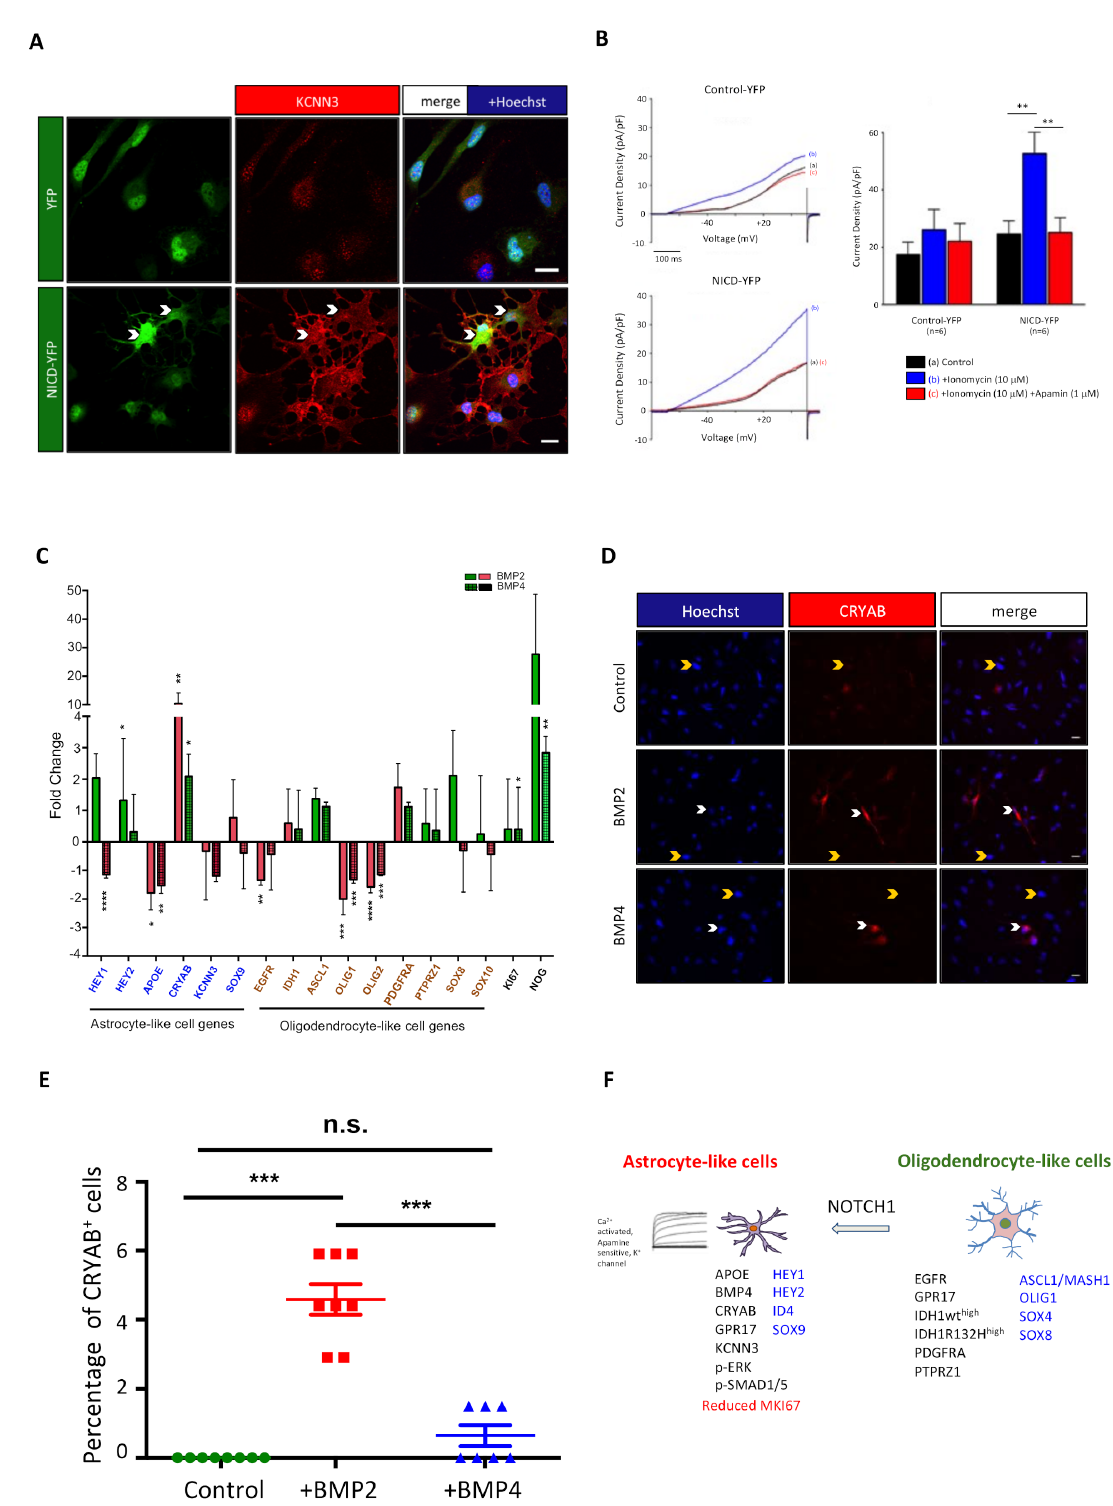
Figure 6. NOTCH1 induces KCCN3/SK3 channels. BMP influence on IDH-DGIIG cell phenotype. ( A ) Immunofluorescence for KCNN3/SK3 channels in YFP and NICD-YFP transduced LGG275 cells. Changes in cellular morphology upon NOTCH1 activation are also visible. Scale bars = 20 µ m. ( B ) KCNN3/SK3 currents induced by NOTCH1 signalling. Channel activity was studied in YFP + cells using the whole-cell patch-clamp technique under a voltage-clamp configuration. Left panels: Representative currents recorded by applying a 600 ms electrical ramp from − 80 mV holding potential to +50 mV in